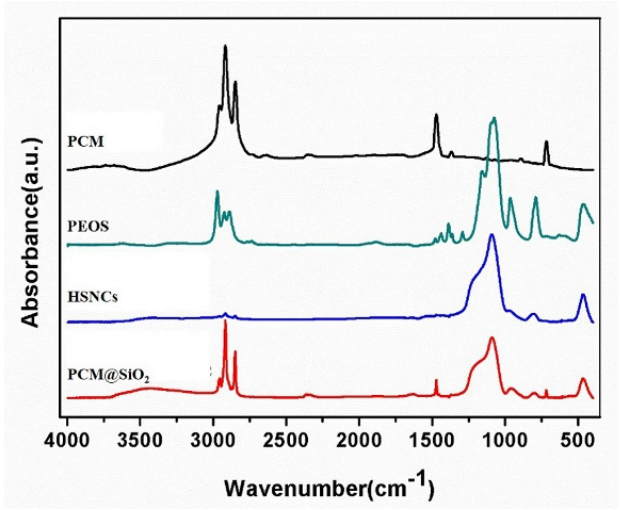
Figure 5. FTIR spectra of PCM, PEOS, hollow silica nanocapsules (HSCNs) and silica - based core- shell nanocapsules (PCM@SiO 2 ).